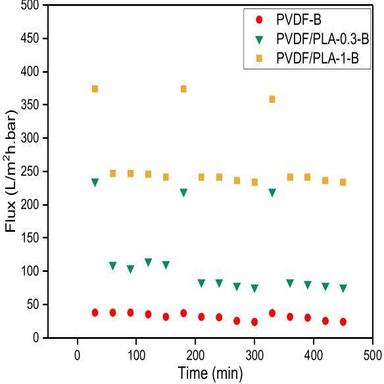
Extended flux profile for the PVDF and PVDF-PLA membranes tested at 1 bar using 1500 mg/L BSA solution for three cycles of operation.